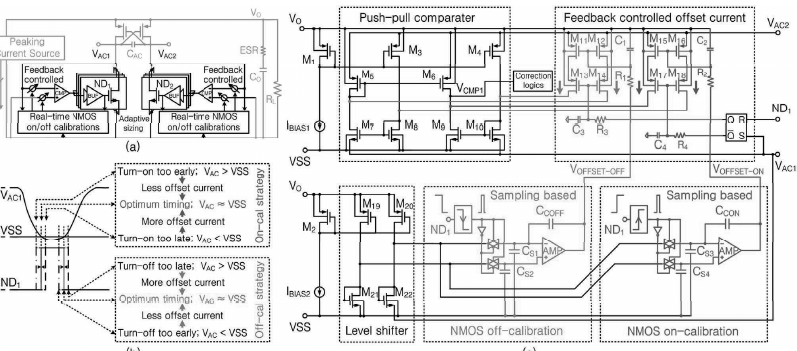
Figure 10. Rectifier proposed in [35]: ( a ) simplified block diagram; ( b ) control strategy; ( c ) detailed schematic of the real-time on/off calibrations for one side of rectifier. Reproduced with permission from C. Huang, IEEE Journal of Solid-State Circuits; published by IEEE,